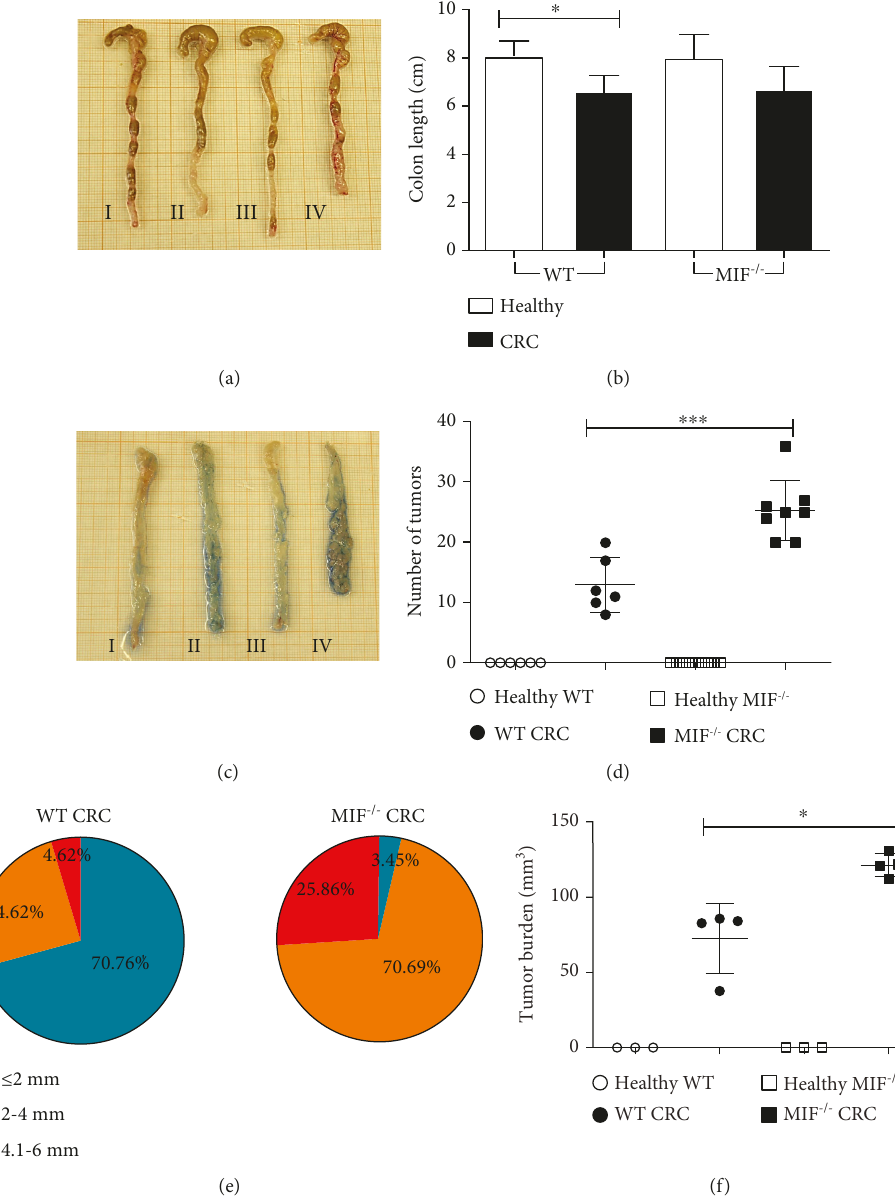
Figure 2: MIF de fi ciency facilitates increased tumor development. After 68 days post induction (d.p.i). (a) Colons from (I) healthy WT, (II) WT CRC, (III) healthy MIF -/- , and (IV) MIF -/- CRC mice were obtained and (b) measured from caecum to anus. Then, (c) the colons were opened longitudinally to measure (d) tumor number and (e) diameter to determine (f) tumor burden. Data are representative of three independent experiments and are plotted as the means ( ± SEM), n = 3 mice per group; ∗ p < 0 05 , ∗∗ p < 0 01 , and ∗∗∗ p < 0 001 . MIF: macrophage migration inhibitory factor; CRC: colorectal cancer; AOM: azoxymethane; DSS: dextran sodium sulfate; d.p.i: days post